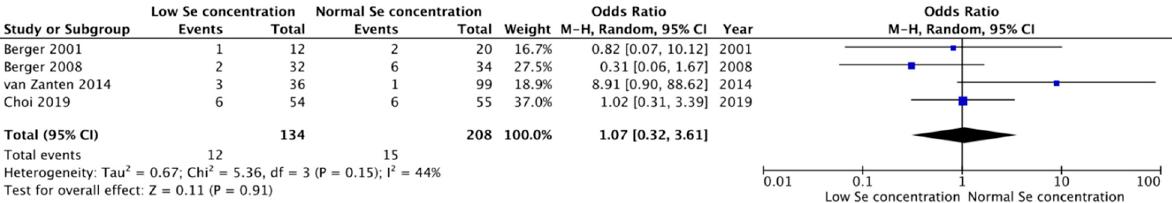
Figure 2. Forest plot of the impact of low serum Se concentration on mortality of patients with severe trauma.